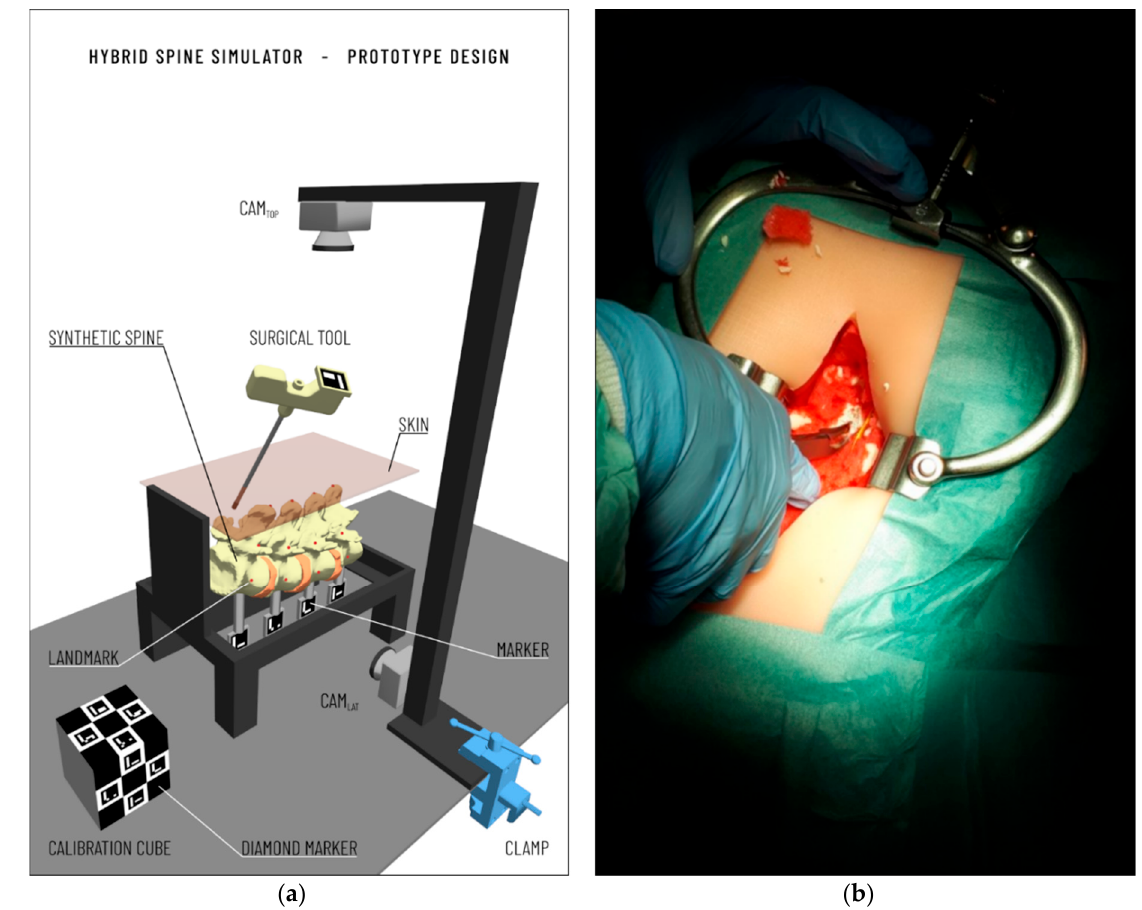
Figure 1. ( a , left ) Overview of the final design of the simulator hardware components: a spine phantom, equipped with markers for tracking, surgical tools with markers, two cameras for tracking, and a calibration cube. ( b , right ) The final appearance of the 3D printed spine embedded in the soft synthetic foam and covered with a skin-like silicone layer.